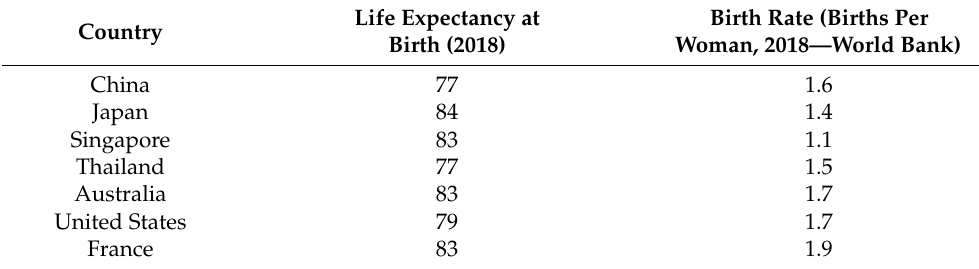
Table 1. Life expectancy and birth rates in selected